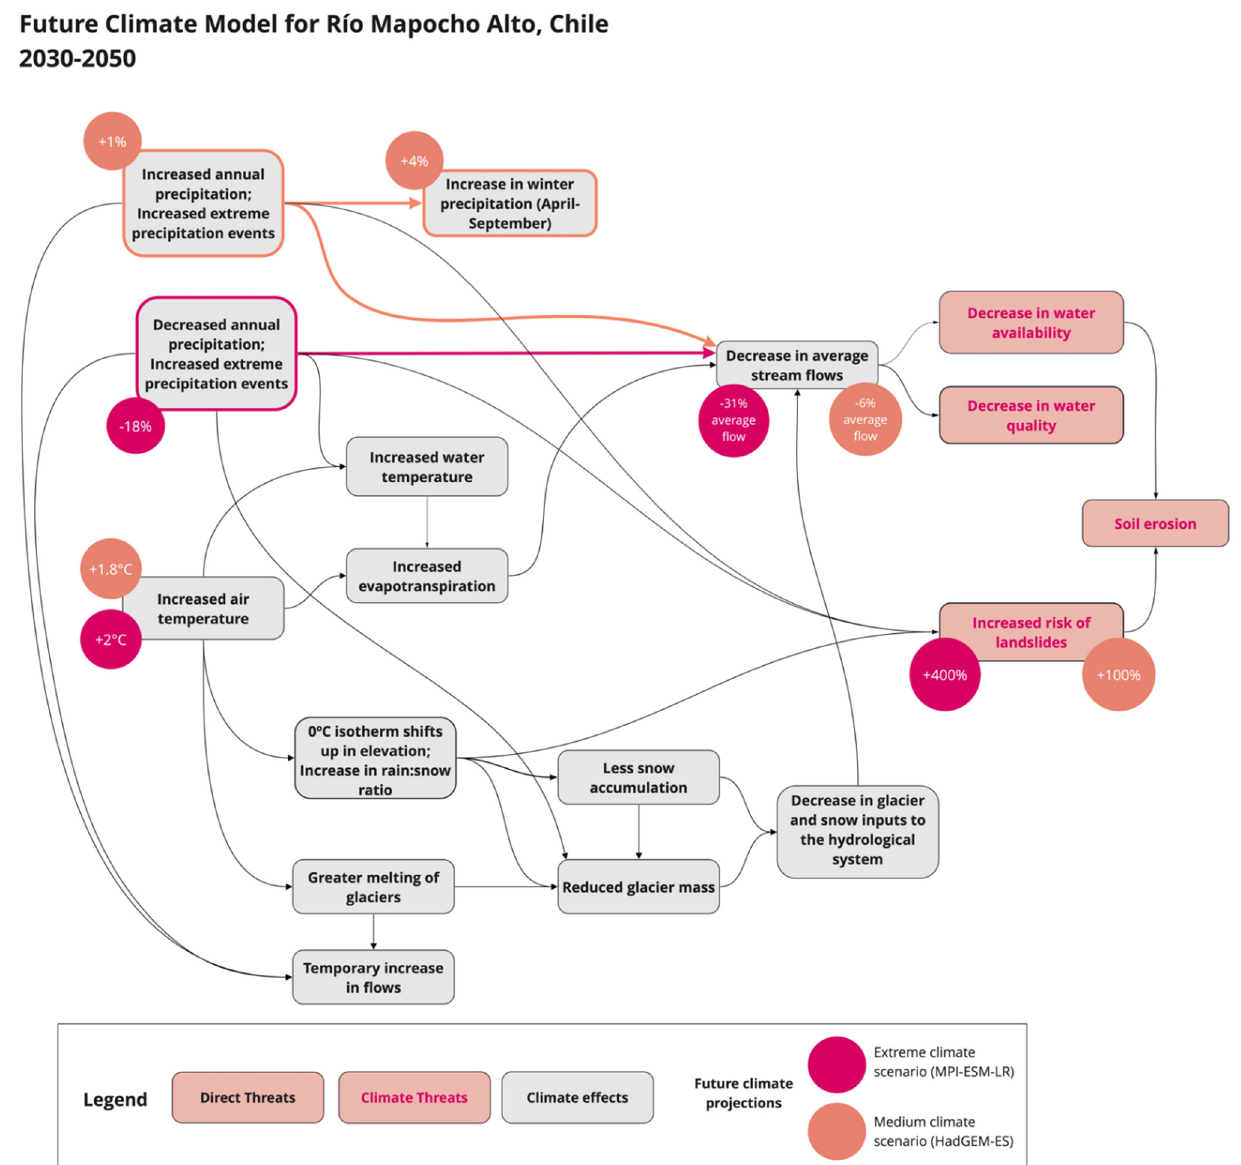
Figure 4. Conceptual diagram of projected and potential climate and hydrological changes of relevance to conservation targets in the Río Mapocho Alto watershed in Chile, showing results from two different climate models. This diagram feeds into the full future situation model for the Río Mapocho Alto watershed depicted below.